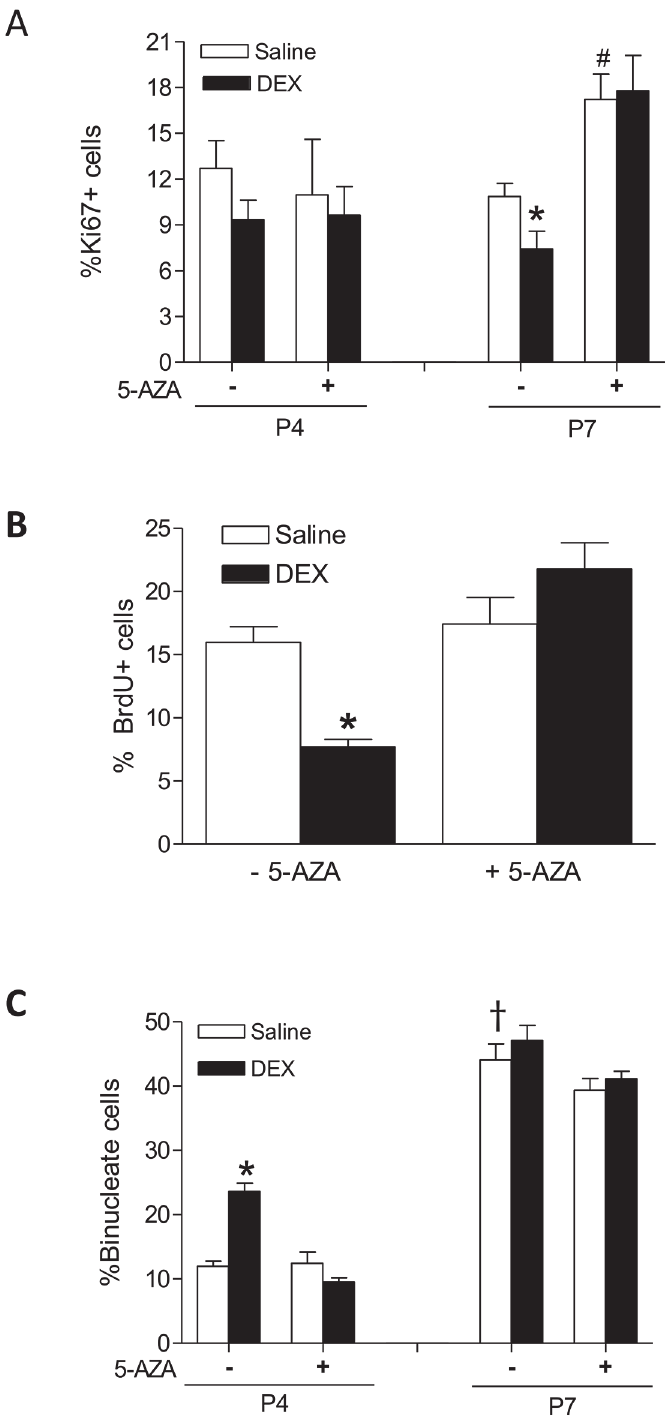
Fig 6. 5-AZA blocks dexamethasone (DEX)-induced effects on cardiomyocyte proliferation and binucleation in neonatal rats. Newborn rats were treated with tapered dose of DEX in the absence or presence of 5-AZA during the first three days of postnatal life. 5-AZA was administered 30 minutes prior to the DEX treatment. Panel A : Cardiomyocytes isolated from day 4 (P4) and day 7 (P7) neonatal hearts were double stained with α -actinin and Ki67, nuclei were stained with Hoechst. Panel B : Cardiomyocytes isolated from P7 neonatal hearts were examined for BrdU incorporation. Panel C : Cardiomyocytes isolated from